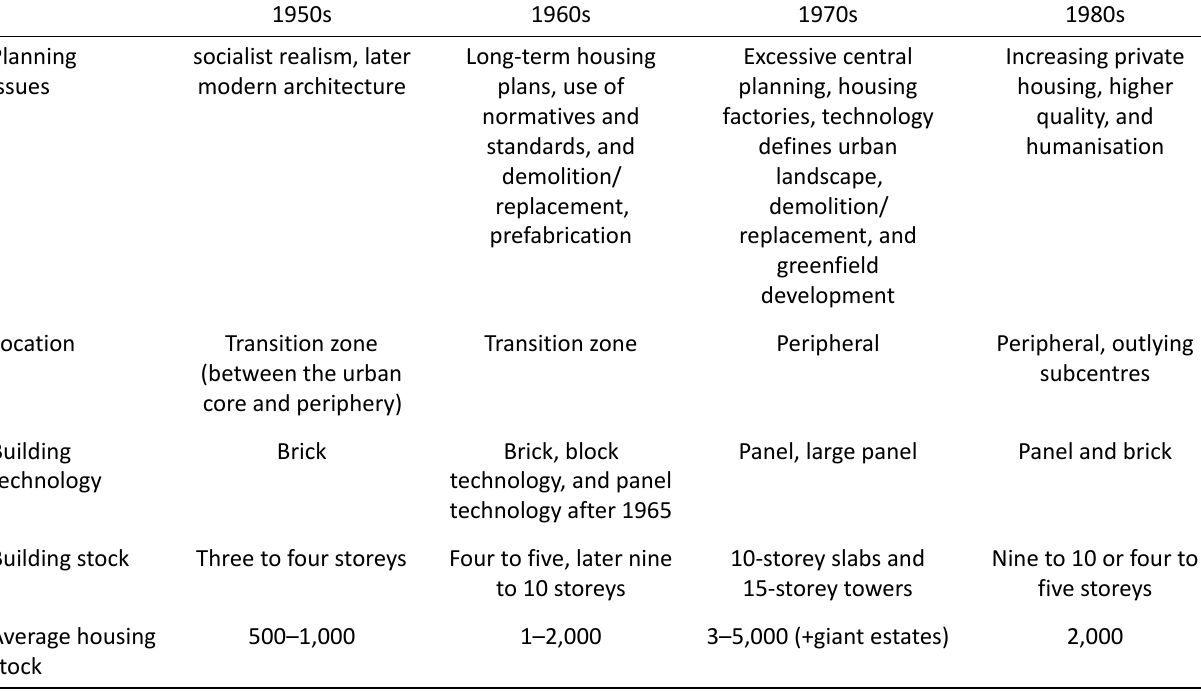
Table 1. Generalised characteristics of generations of HEs in